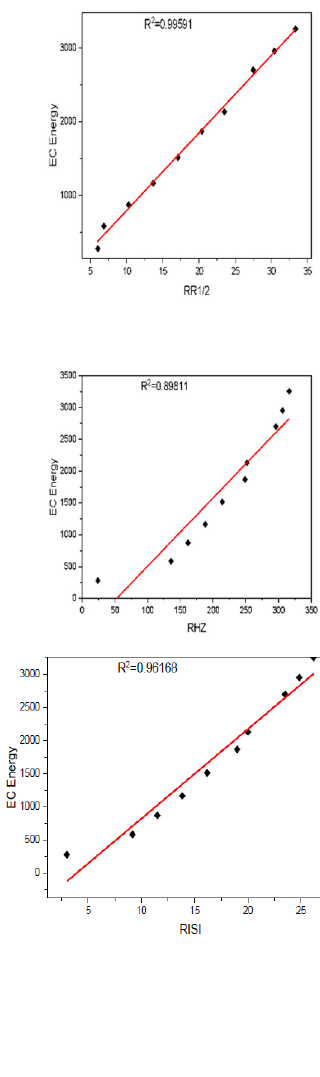
Figure 2. ECE and reverse descriptors.